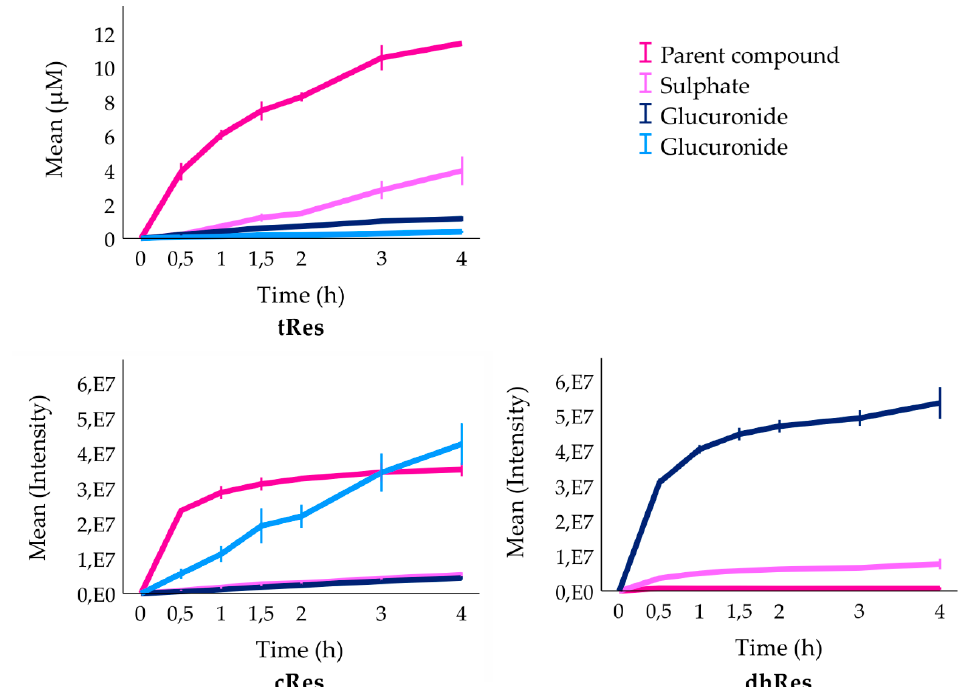
Figure 5. The changes of parent compounds and their metabolites on the basolateral side of inserts in Transwell TM cellular system. Values obtained from LC/MS for tRes are expressed as mean concentration ± standard deviation, n = 4; for cRes and dhRes values are expressed as mean intensity ± standard deviation, n = 4 and n = 5, respectively (see Materials and methods).